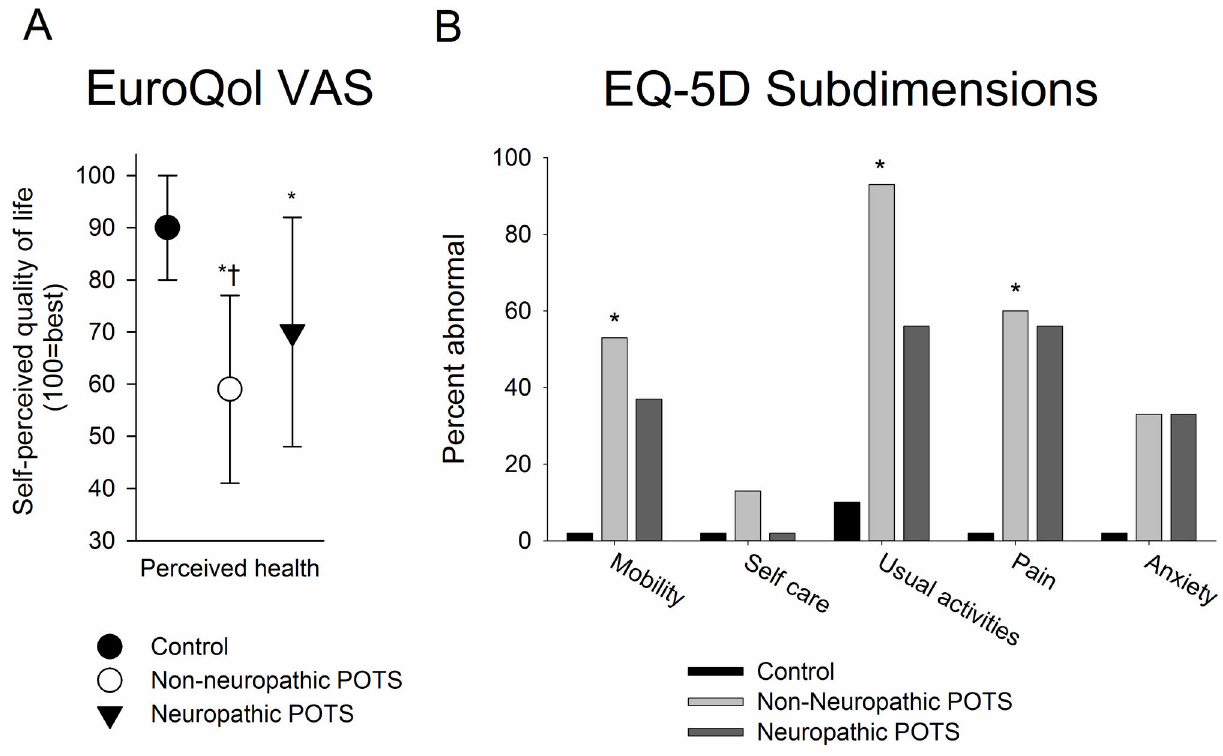
Figure 2. Results of European Quality of Life Questionnaire. A. The EuroQol VAS for self-perceived healthy-related quality of life (Score of 100 = best imaginable health state, 0= worst imaginable health state). The non-neuropathic POTS had the lowest perceived quality of life, while the neuropathic POTS subjects had lower self-perceived health than control subjects. * p < 0.01 vs. controls, † p <0.01 vs. neuropathic POTS (ANOVA with Tamhanes T2 post-hoc test). The EuroQol 5D (B) shows the individual sub-dimensions with the percent of individuals reporting abnormalities shown. Significant differences in mobility, usual activities and pain were noted between groups (*=P<0.05, Fishers exact test). A greater percent of non-neuropathic POTS subjects reported self-perceived difficulty across all sub-dimensions than control and neuropathic POTS subjects (with the exception of anxiety which was reported with the same frequency as neuropathic POTS